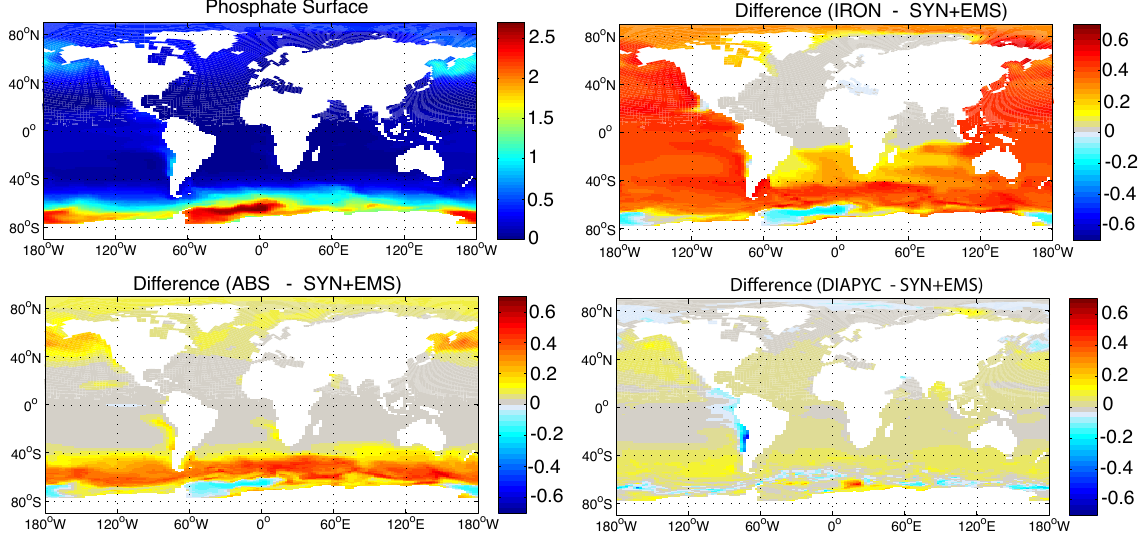
Fig. 19. Annual mean phosphate surface concentration (µmoll − 1 ) for 2007 for SYN+EMS as a reference and differences from this for IRON, ABS and DIAPYC sensitivity